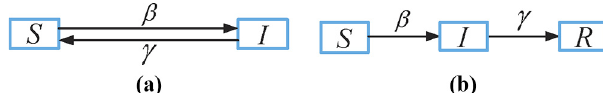
Figure 1. The state transition of (a) SIS model and (b)